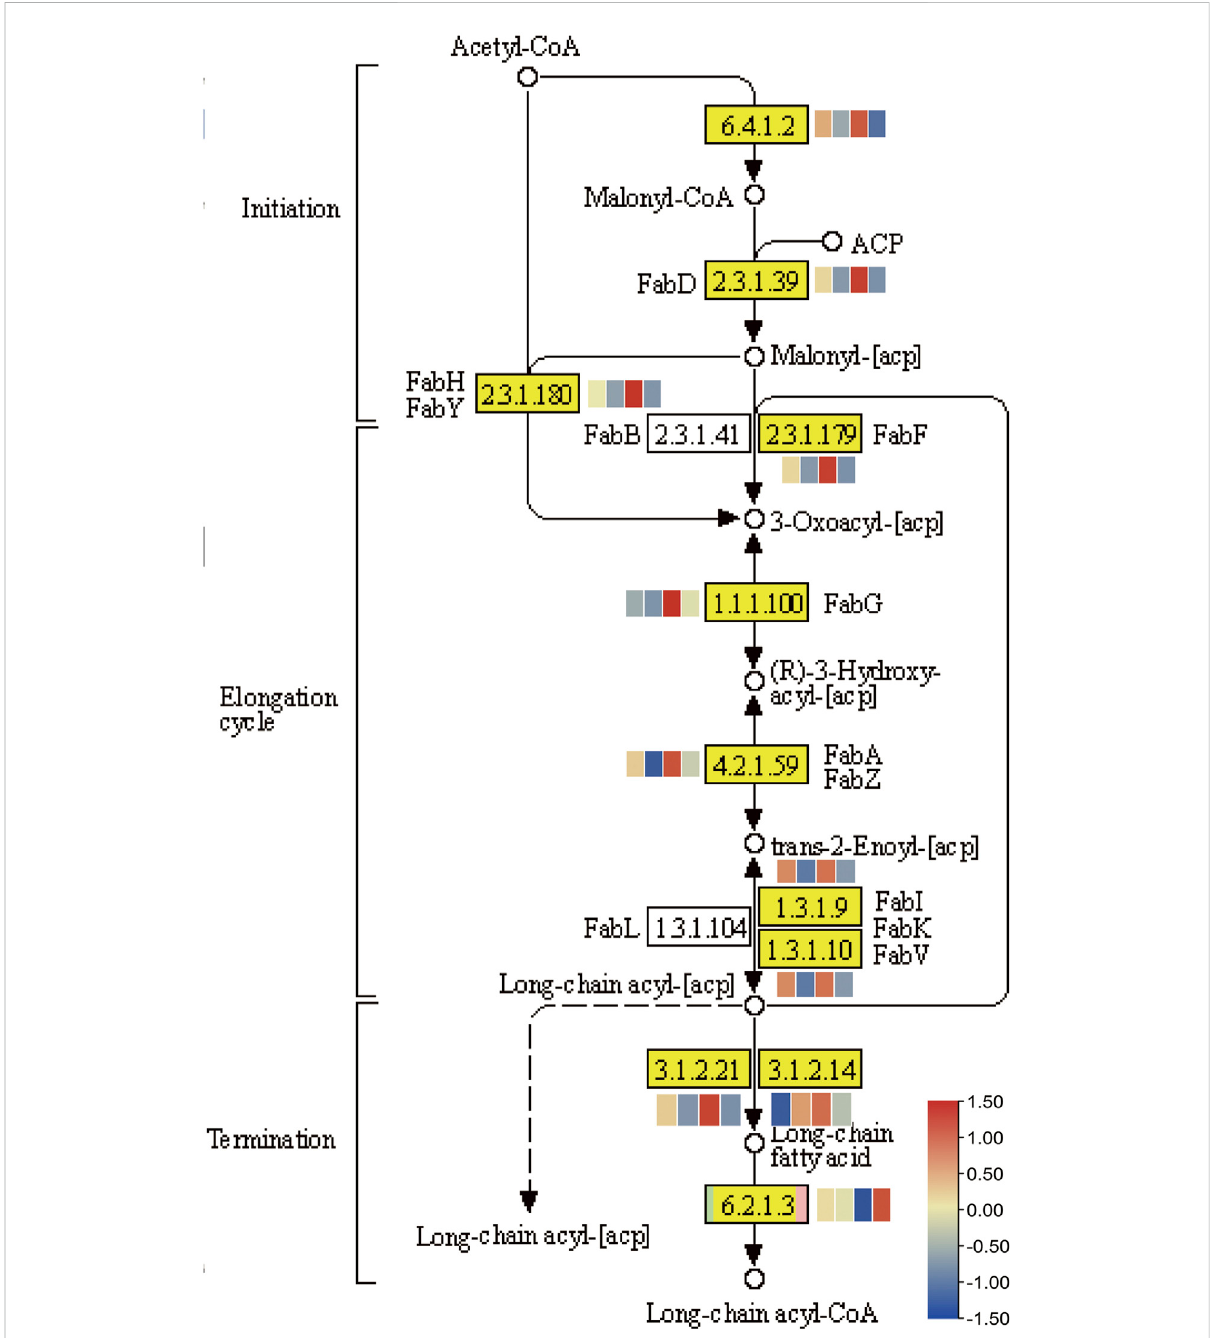
FIGURE 8 The KEGG pathway of fatty acid biosynthesis. The heatmap was generated by using the FPKM values of Guichao 2 under normal condition, Guichao 2 after cold treatment, NIL176 under normal condition, and NIL176 after cold treatment with row